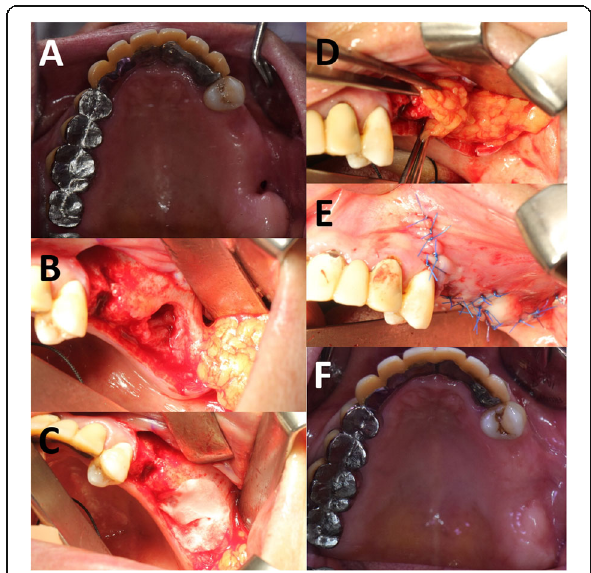
Fig. 2 The three-layer technique using collar tape, a BFP, and a buccal advancement flap. a Pre-operative state. b Bony defect. c Collagen